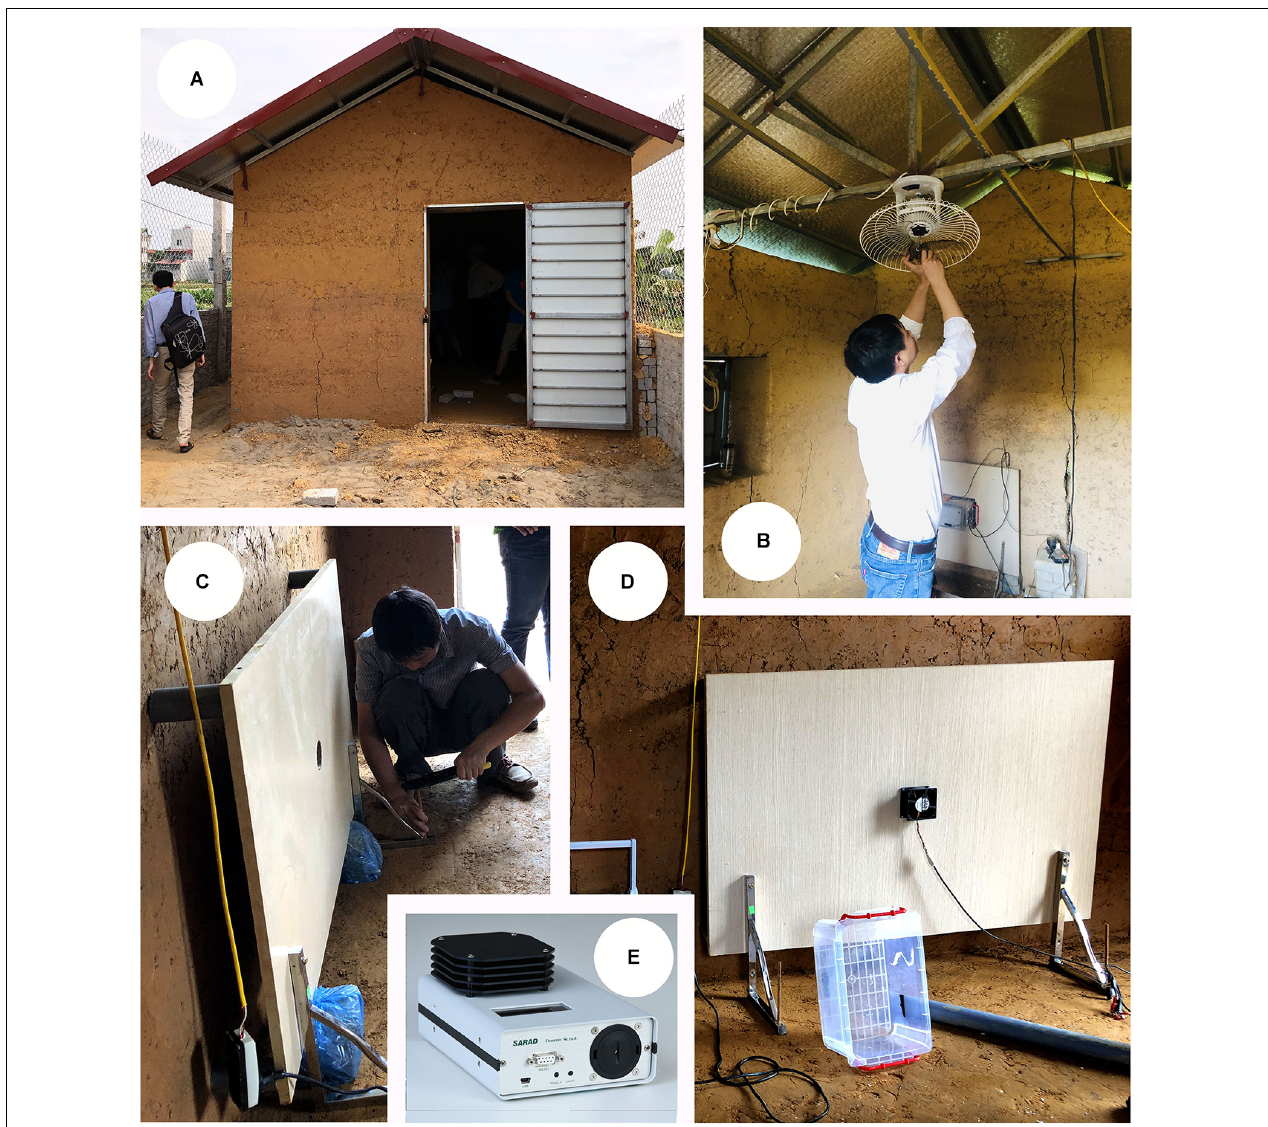
FIGURE 3 | (A) Mud house near Hà Nô.i that was constructed with terra rossa from Hà Giang Province and was completed in November 2017. (B) An oscillatory ceiling fan provides optional turbulence for room air. The background shows the SARAD R (cid:13) Thoron Scout assembly in position ∼ 50 cm above the floor. (C) White board with central hole to draw air from close to the mud wall. (D) White board with fan attached. The perforated translucent polyethylene container will house the (E) Thoron Scout when attached against the white